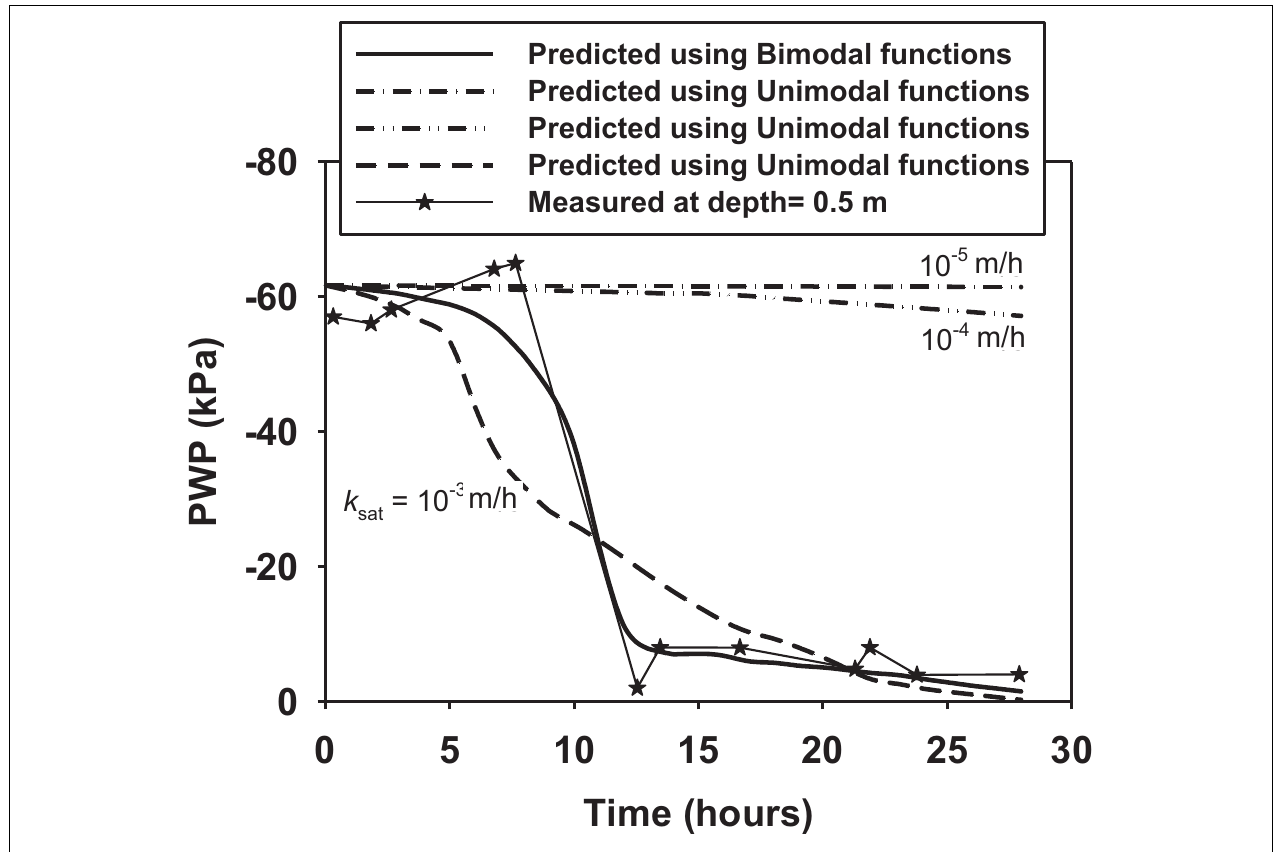
FIGURE 6 | Comparison between measured PWP and predicted PWP at the depth of 0.5